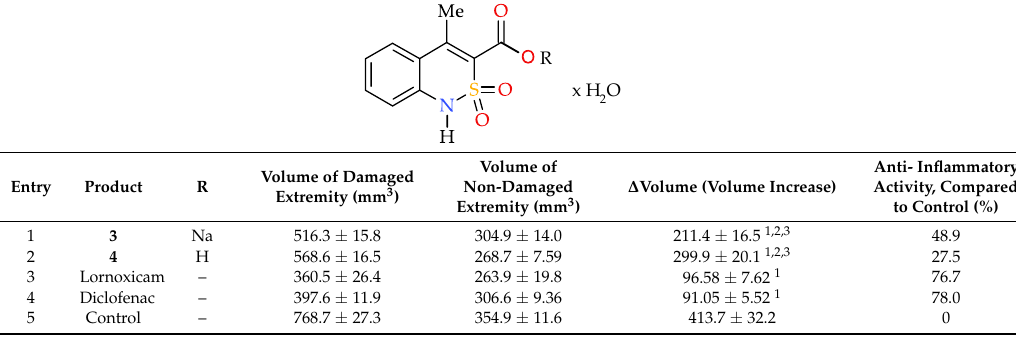
Table 2. The Analgesic Activity of Sodium Salt 3 , Acid 4 , and Reference